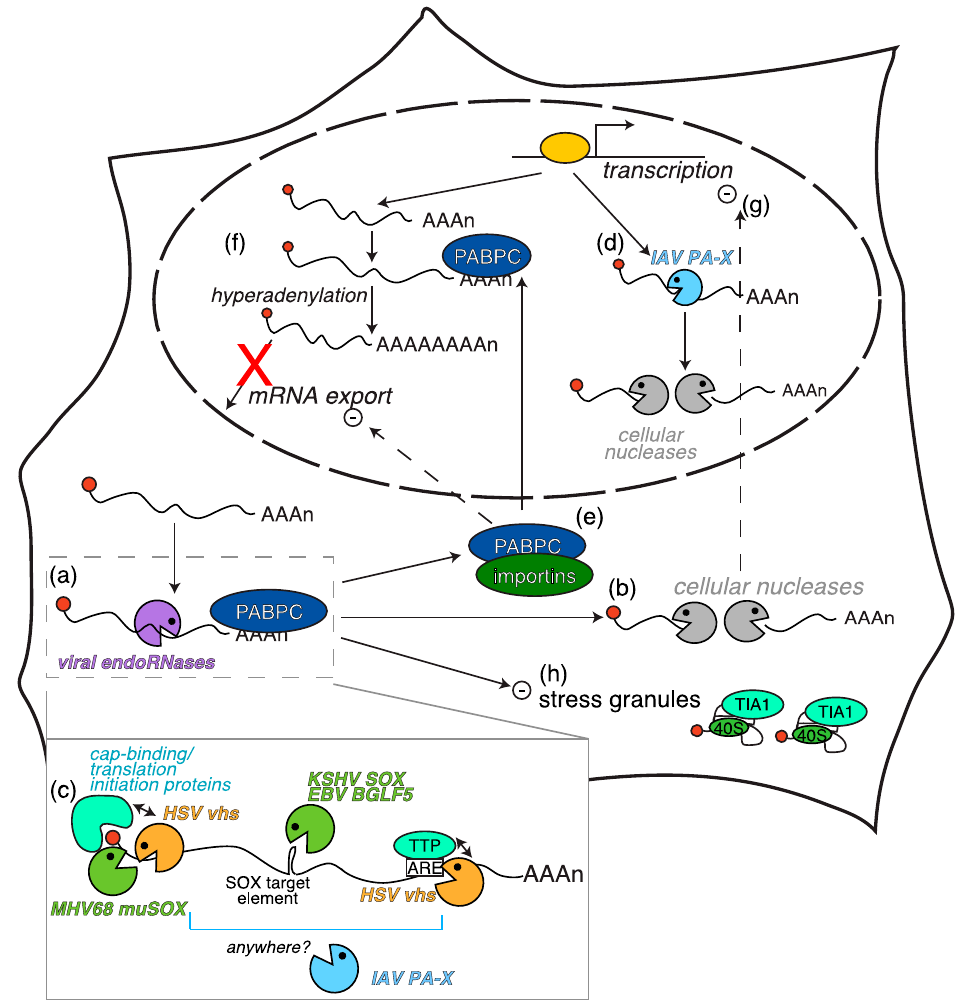
Figure 2. RNA degradation by herpesviral and IAV RNases and its downstream consequences. Viral host shutoff RNases cut mRNAs internally ( a ), leading to fragment degradation by cellular exonucleases ( b ). The location of the cut sites differs depending on the RNase (( c ), inset). IAV PA-X also differs by potentially associating with targets in the nucleus ( d ). Secondary consequences of the RNA degradation include: ( e ) association of PABPC with importins and nuclear accumulation of PABPC, which results in mRNA hyperadenylation and export block ( f ); ( g ) a feedback inhibition of transcription mediated by the cellular exonucleases; ( h ) inhibition of formation of cytoplasmic stress granules. In contrast to the position-directed specificity of vhs, KSHV SOX cuts RNAs in a sequence-specific manner [33,54] (Figure 2). This was first observed in reporter mRNAs, because knockdown of cellular exonuclease uncovered the presence of SOX degradation intermediates of defined and reproducible sizes [33]. This result was surprising because an RNA-seq study of cells transfected